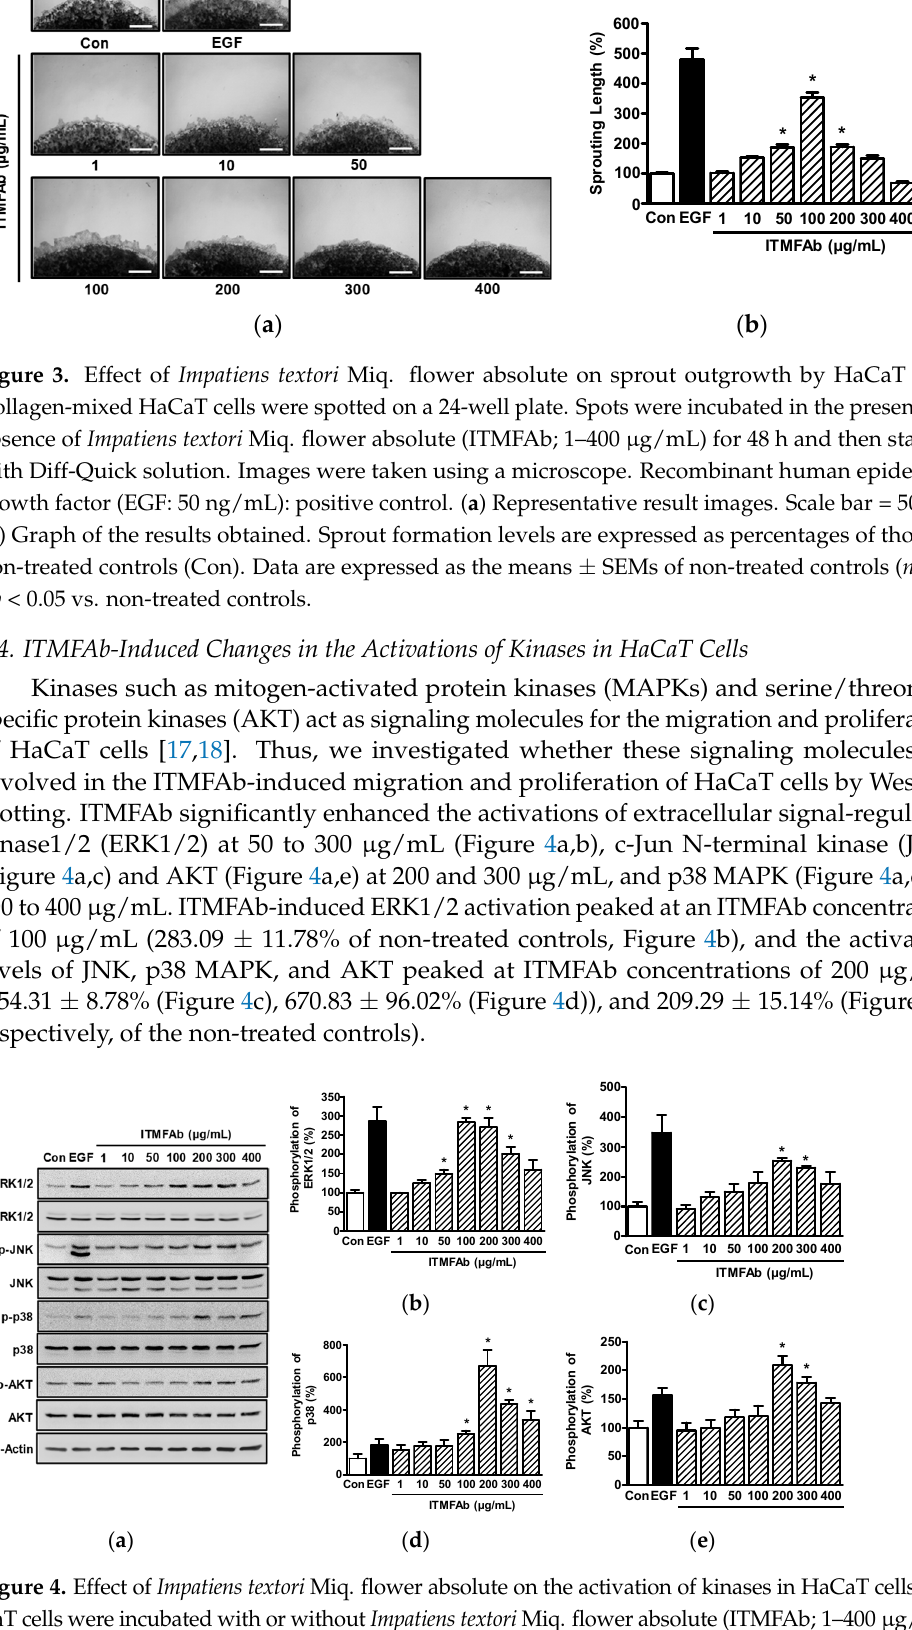
sentative images of immunoblotting results ( b – e ) Graphs of phosphorylated ERK1/2 ( b ), JNK ( c ),